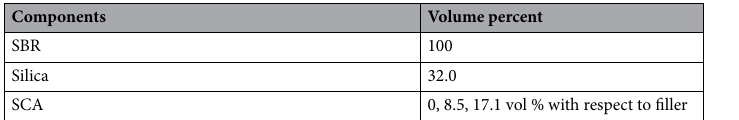
Table 1. SBR composite formulation. The composites were vulcanized at 150 °C for 12 min. Small amounts of oil, wax, antioxidant, ZnO, stearic acid, sulfur, and accelerators were included as other